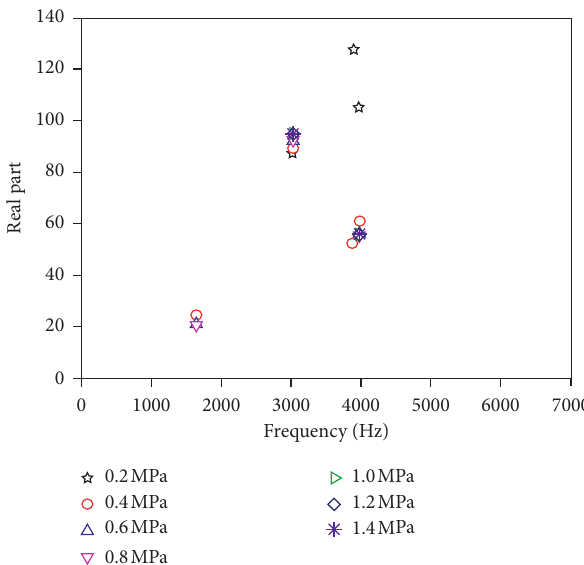
Figure 5: Results of complex modal analysis of the brake under different brake oil